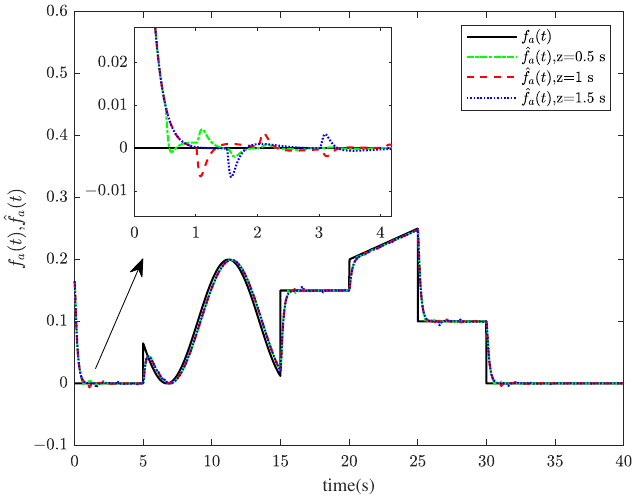
Figure 1. The actuator fault f a ( t ) and its estimation ˆ f a ( t )